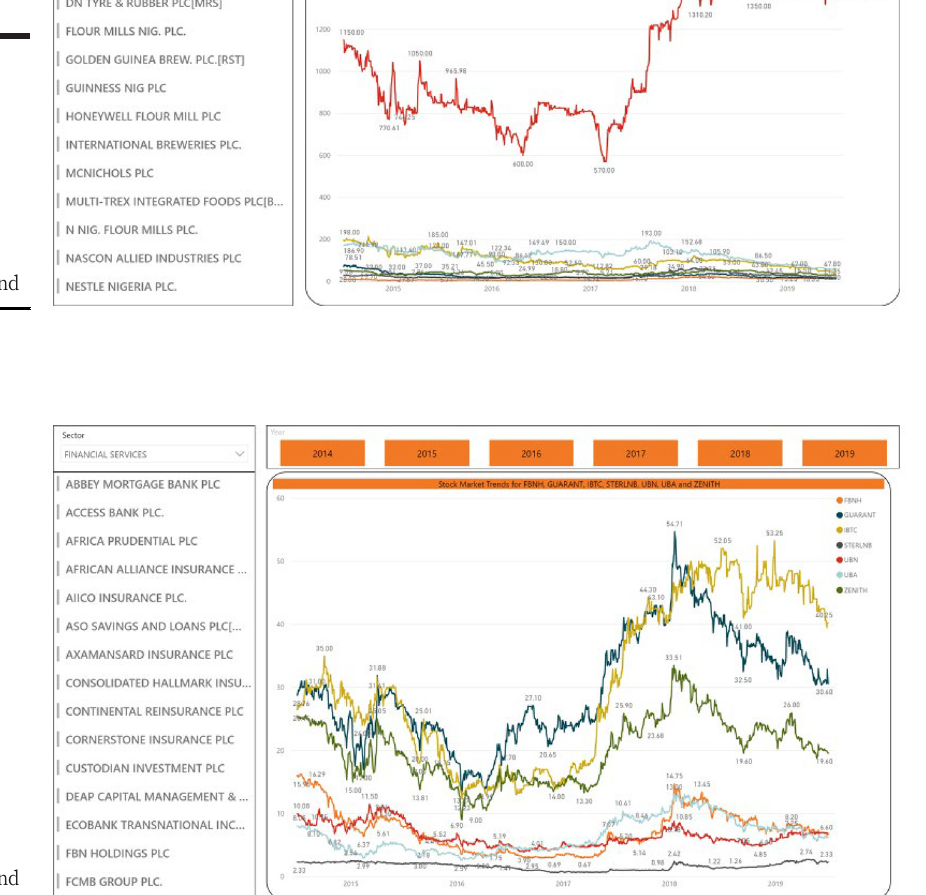
Figure A4. Financial services selected stocks